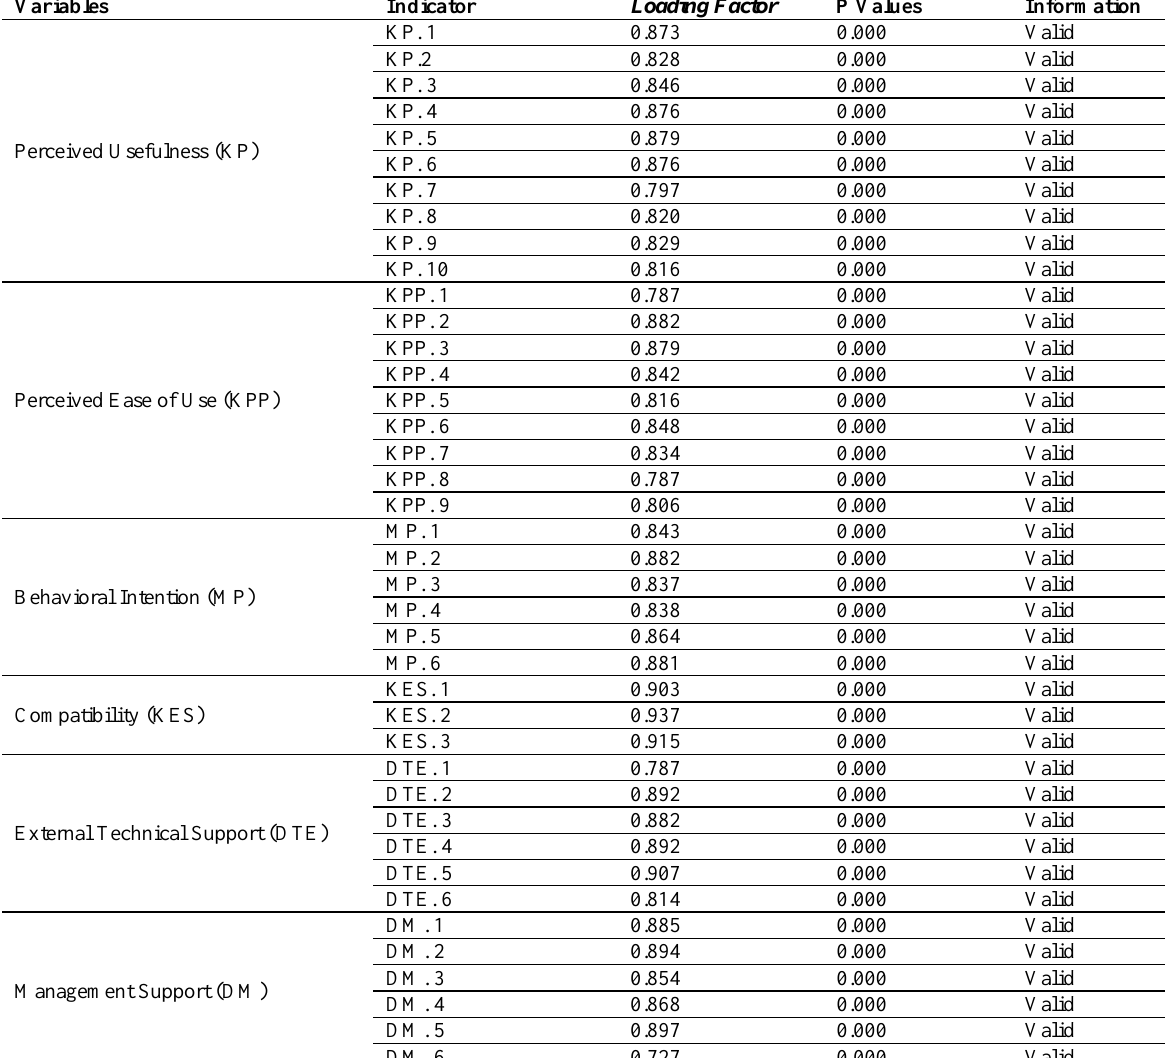
Table 1: Reflective Construct Convergent Validity Test